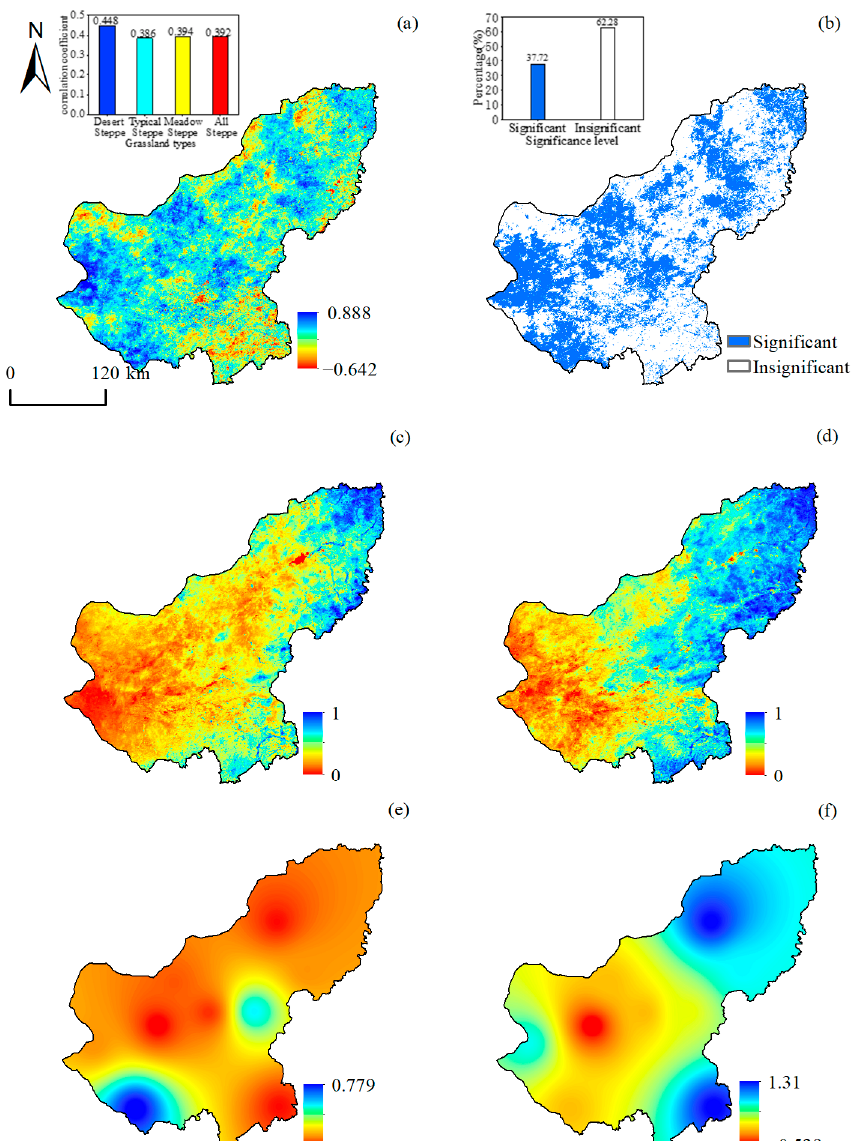
Figure 9. Annual NDVI and EDI correlation coefficient and significance test spatial distribution in Xilin Gol from 2000 to 2018. ( a ) Spatial distribution of the correlation coefficients, ( b ) spatial distribution of the significance tests, ( c ) spatial distribution of the NDVI in 2000, ( d ) spatial distribution of the NDVI in 2018, ( e ) spatial distribution of the EDI in 2000, and ( f ) spatial distribution of the EDI in 2018. (Significant is p < 0.05; Insignificant is p ≥ 0.05.).